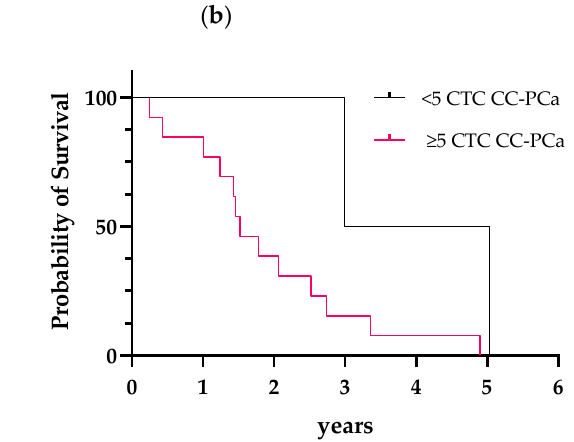
Figure 8. Kaplan–Meier curves of OS according to CTC count determined with ( a ) CC-EpCAM and with ( b ) CC-PCa: ( a ) The patients with <5 CTCs and ≥ 5 CTCs showed a difference in OS (2.1 years versus 0.93 years (HR 0.53, 95% CI: 0.13–2.1)). ( b ) The patients with <5 CTCs and ≥ 5 CTCs showed a difference in OS (4.0 years versus 1.5 years (HR 0.33, 95% CI: 0.11–0.97)). Patients (20%) evaluated with CC-PCa and with <5 CTCs survived a median of 4.0 years, and patients (80%) with ≥ 5 CTCs survived a median of 1.5 years. The HR, referring to <5 CTCs or ≥ 5 CTCs, was 0.33 (95% CI: 0.11–0.97, Figure 8b). In cohort 2, we reached a